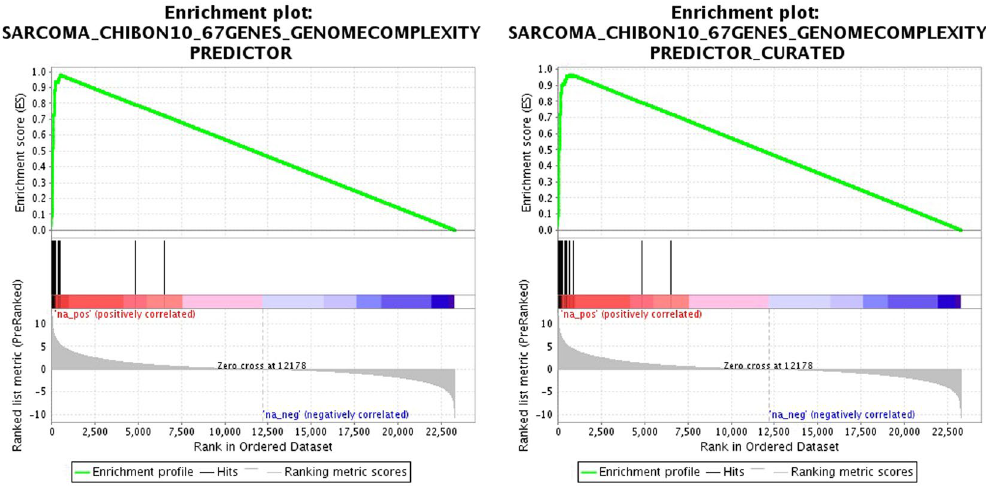
Figure 1. Enrichment plots of the reduced (left) and full (right) CINSARC signatures. Genes are ranked according to their individual prognosis given in PRECOG (poor and good prognoses in the left and right sides, respectively), represented by red and blue segments. Across these segments, CINSARC genes are marked by vertical black lines. The enrichment score (green plot) corresponds to a running-sum statistics: for each gene, if part of the signature, a positive value is added and a negative one